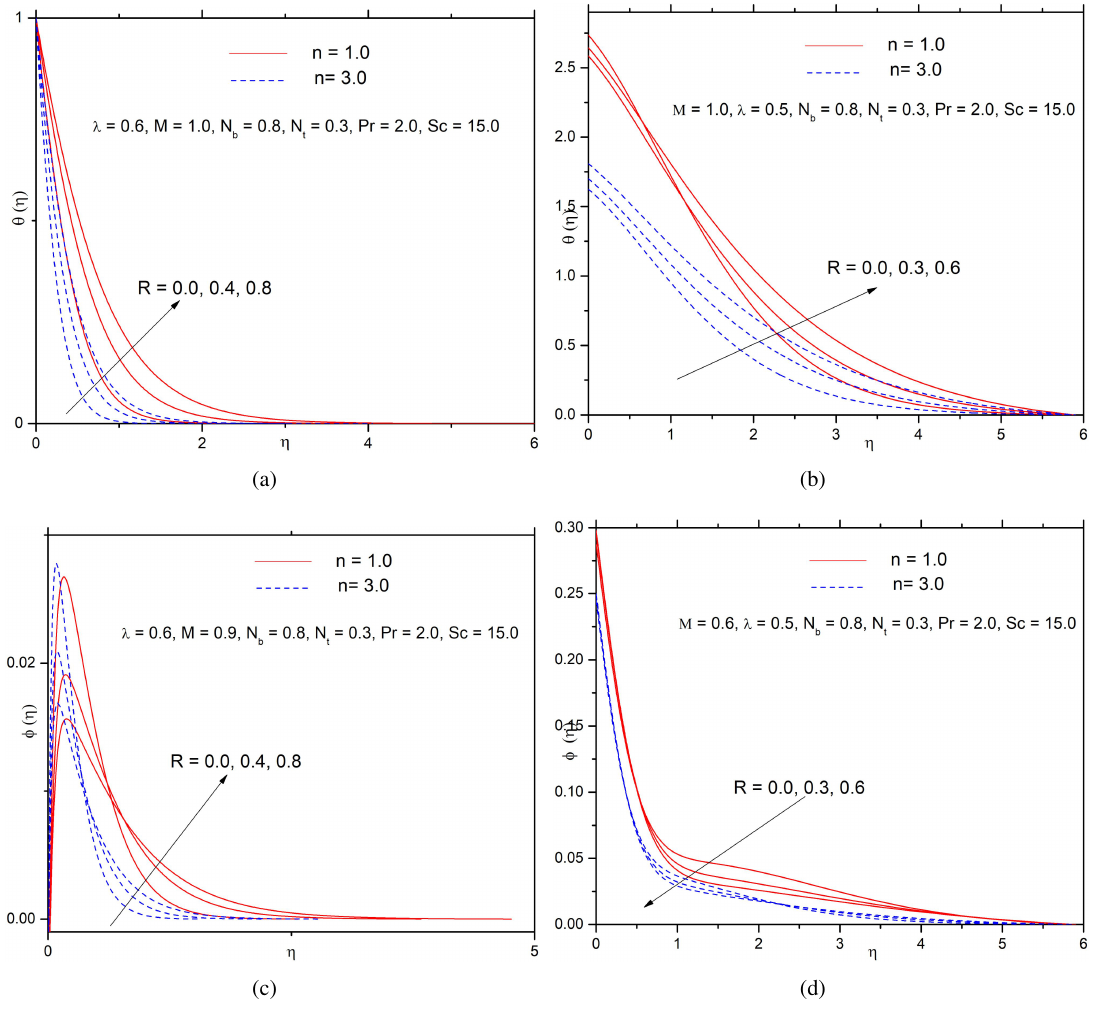
Fig. 6 Influences of R , radiation parameter on temperature θ ( η ) for (a) CWT and (b) PHF and on nanoparticle volume fraction ϕ ( η ) for (c) ZMF and (d)